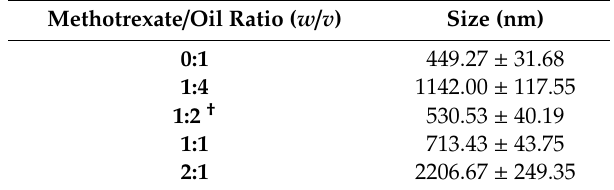
Table 4. Effect of methotrexate / oil ratio ( w / v ) on droplet size of double emulsion (at 25 ◦ C, n = 3, mean ± SD). Methotrexate / Oil Ratio ( w / v ) Size (nm) 0:1 449.27 ±